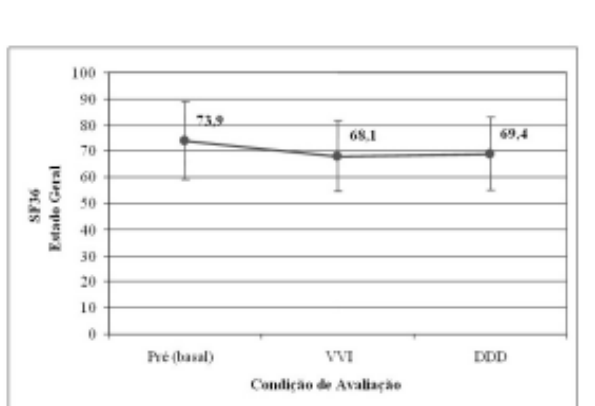
Fig. 4 - Qualidade de vida avaliada pela vitalidade (p=0,593), nas condições Pré (basal), VVI e DDD, dos pacientes com cardiopatia chagásica e bloqueio atrioventricular. Total de pontos (SF36) da avaliação do estado geral representados em média e desvio-padrão; DDD: condição do paciente após 90 dias de estimulação atrioventricular; p: nível descritivo do teste de variância para medidas repetidas; Pré (basal) condição do paciente em estimulação ventricular exclusiva na seleção do estudo; VVI: condição do paciente após 90 dias de estimulação